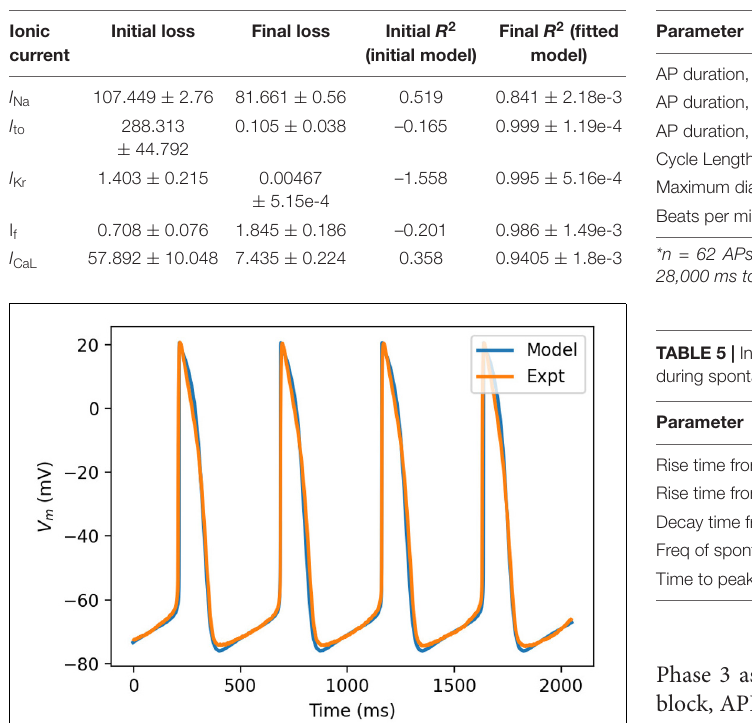
TABLE 4 | Comparison of action potential parameters.